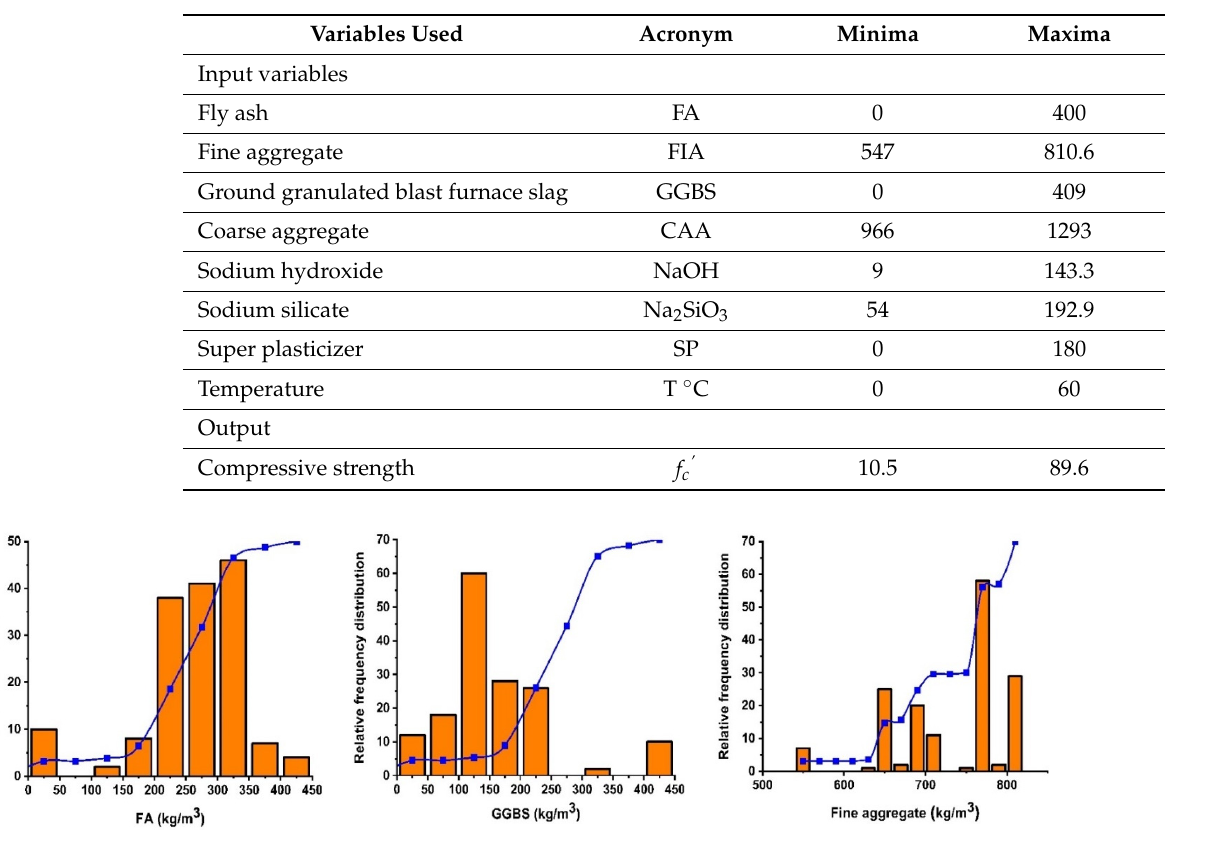
Table 2. Contribution of parameters with